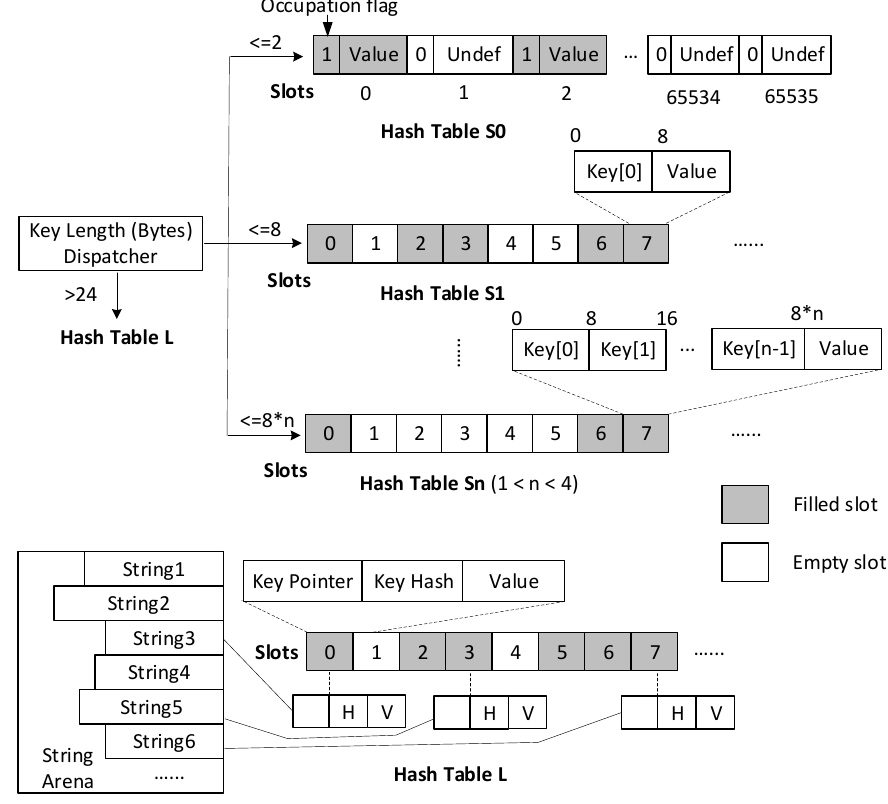
Figure 5. Architecture of SAHA with multiple hash tables to store strings with different length